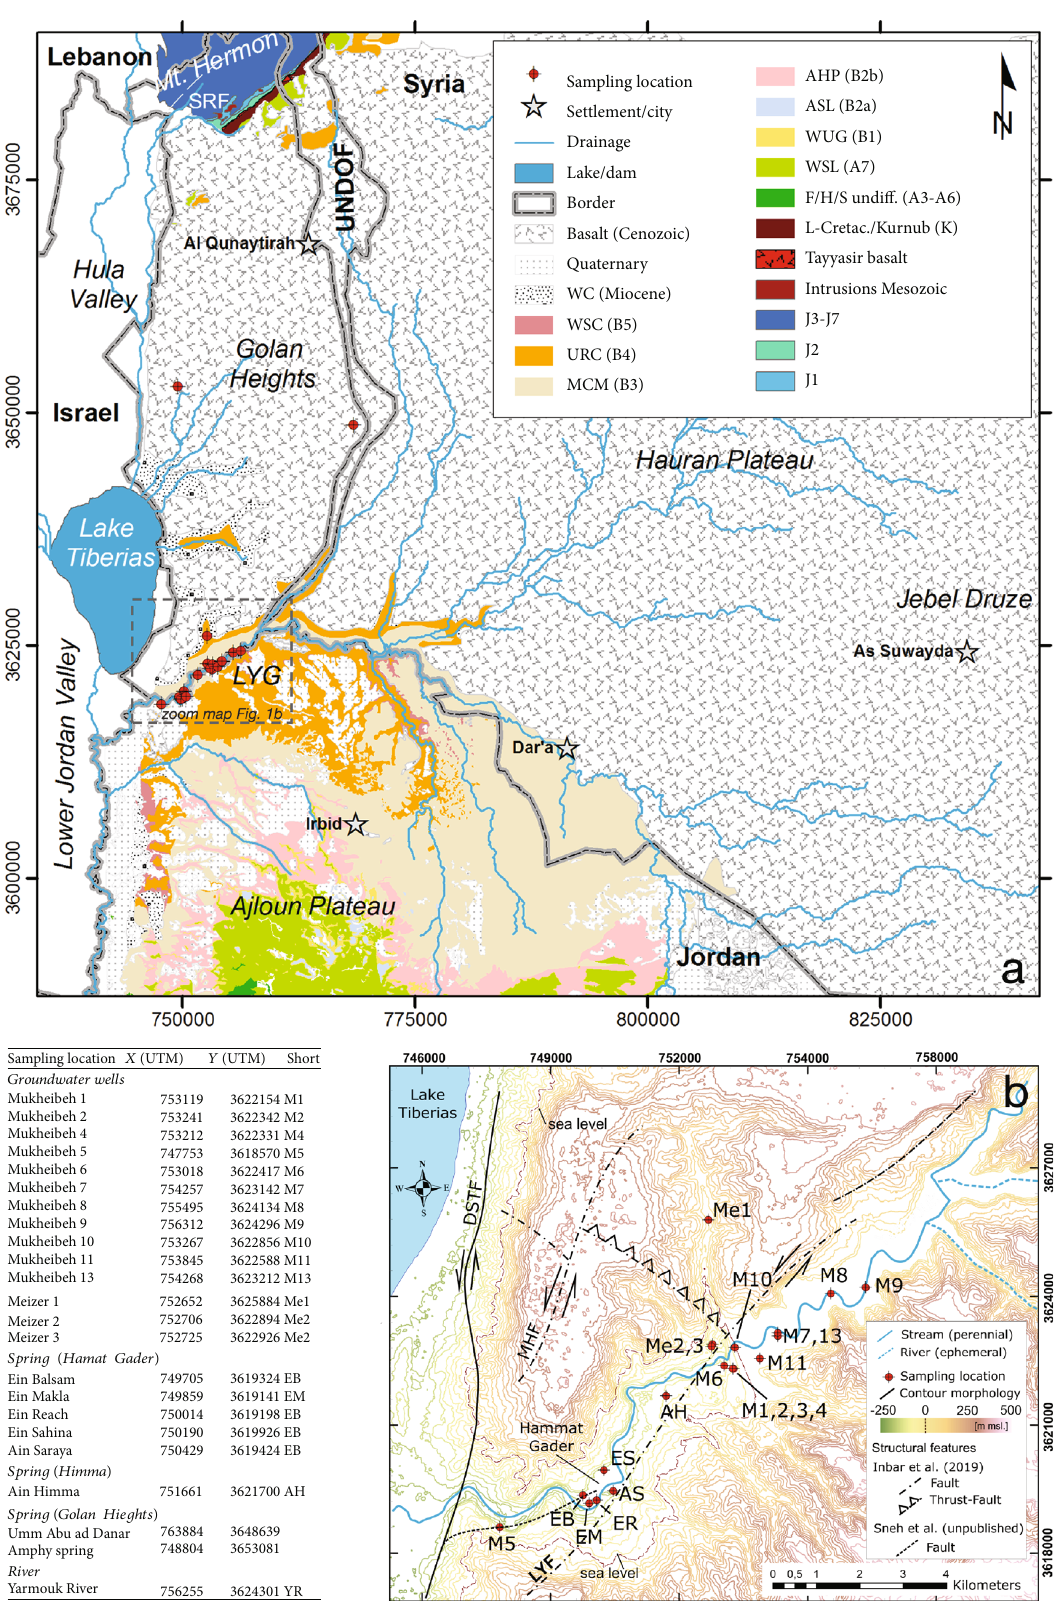
Figure 1: Overview of the study area, showing geological background (a) and sampling locations (b) including structural features recently introduced by Inbar et al. [15] and Sneh